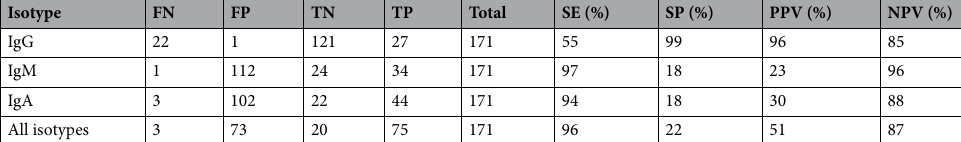
Table 3. Performance of ELISA based on Luminex diagnosis as gold standard. The analysis included samples from mothers (N = 168) and cord (N = 3). The section of “All isotypes” refers to the performance based on seropositivity by any of the three isotypes. FN false negative, FP false positive, TN true negative, TP true positive, SE sensitivity, SP specificity, PPV positive predictive value, NPV negative predictive value.